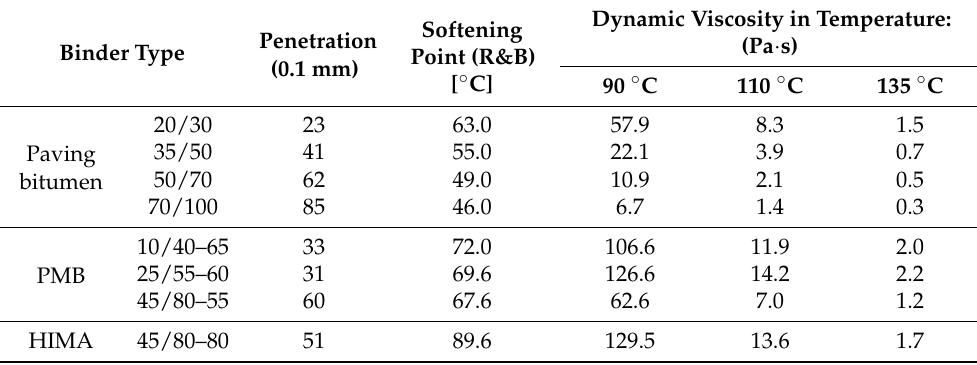
Table 1. Basic properties of the